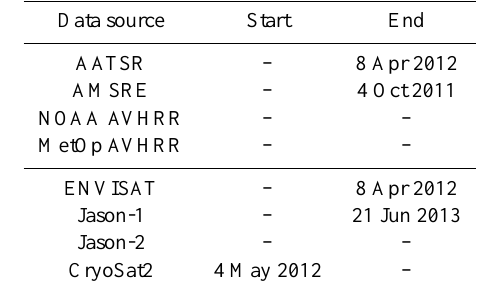
Table 2. Availability of satellite SST (upper half) and satellite al- timeter (lower half) observations used within the operational im- plementation of FOAM v12 and the trials described in Sect.